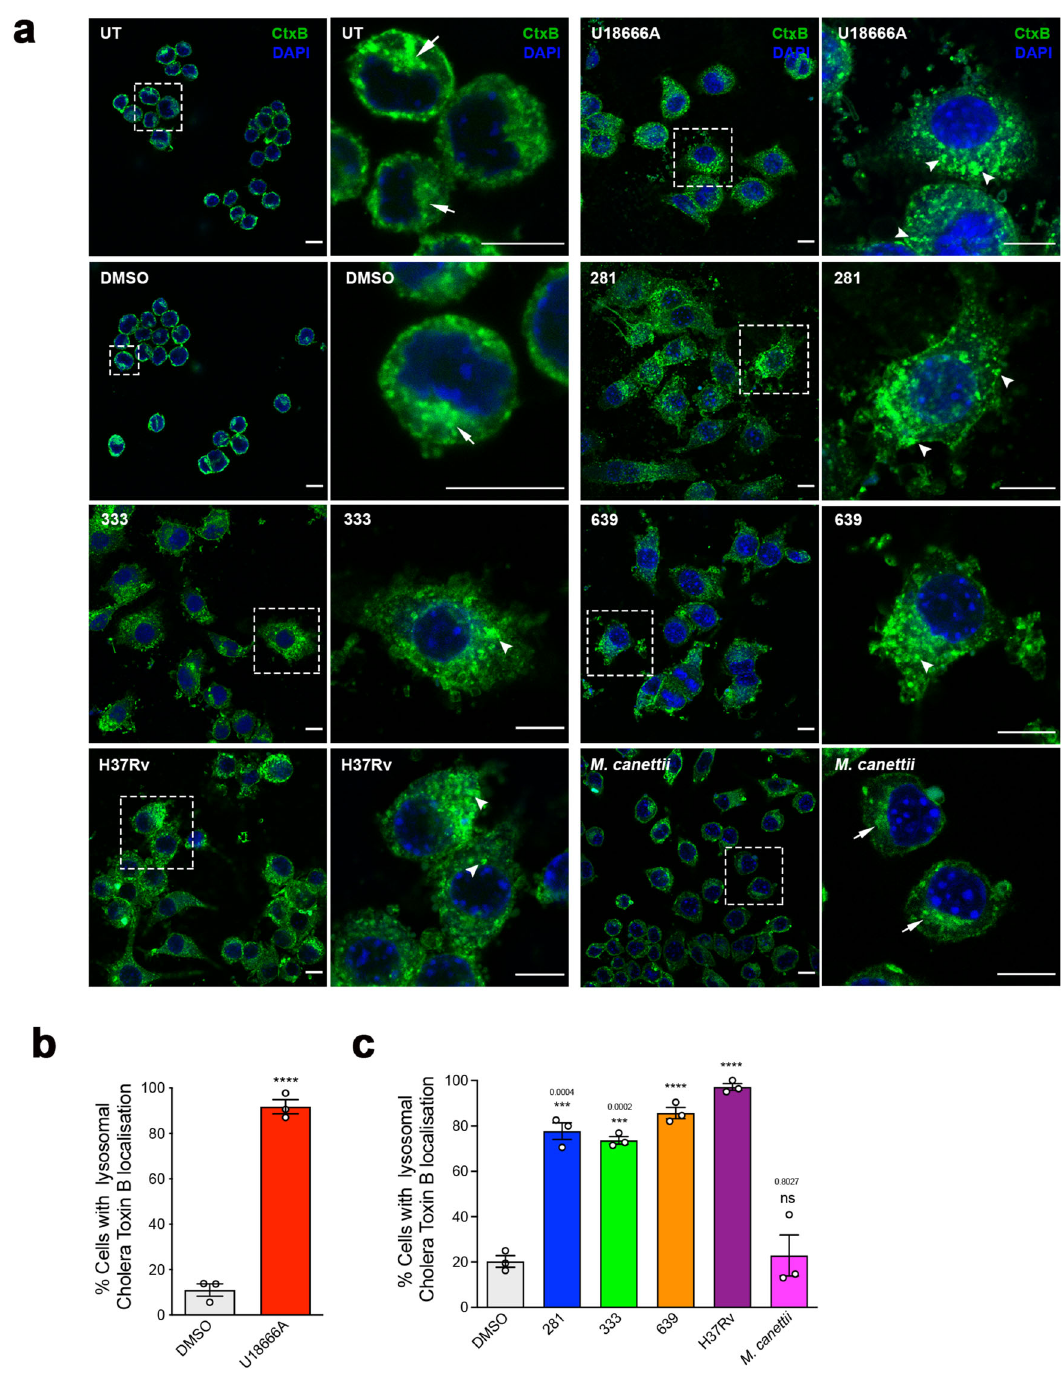
Fig. 6 | Mtb lipids affect GM1 traf fi cking in RAW 264.7M Φ . a Confocal micro- scopy images of RAW 264.7M Φ treated with vehicle (DMSO), U18666A, or mycobacterial lipids and pulse-chased with cholera toxin B subunit (green). Nucleus is stained with DAPI (blue). For each pair, right image is a higher magni- fi cation of the region outlined in the left image. Untreated, vehicle and M. canettii lipidtreatedcellsshowapredominantlyGolgipatternofstaining,indicatedbythe white arrows. U18666A and lipids from Mtb strains induce a punctate pattern, consistent with lysosomal distribution (white arrowheads). Scale bar represents 10 μ m. b Percentage of vehicle and U18666A treated cells with lysosomal cholera